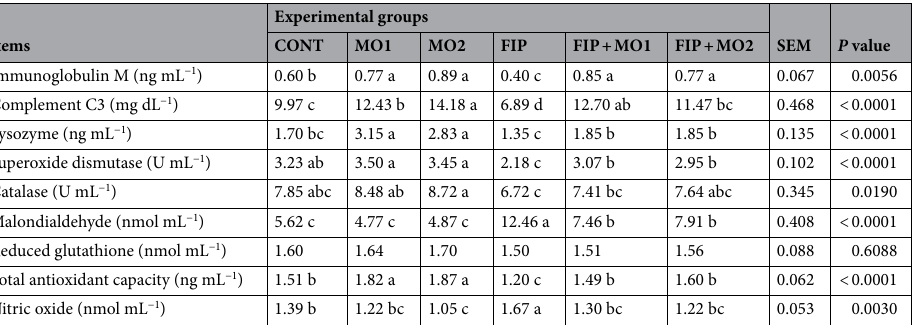
Table 6. Serum immune and antioxidant biomarkers of Nile tilapia groups during the present study. Data represent means ± S.E.M—means having different letters in the same row are significantly different at P < 0.05.